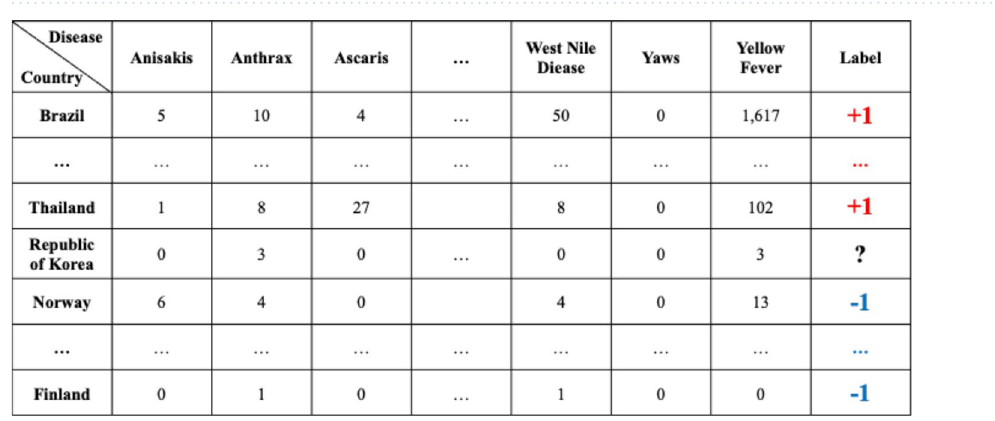
Figure 5. Data set composition for the prediction model for each disease by country: For example, in the first row, the data set of diseases for Afghanistan is listed in the first row of Table B of Fig. 4. Nodes with ‘ + 1 ′ indicate that the reports related to the disease occurred more than once in the country, while nodes with ‘ − 1 ′ indicate that the reports related to the diseases never occurred in Table A of Fig. 4.